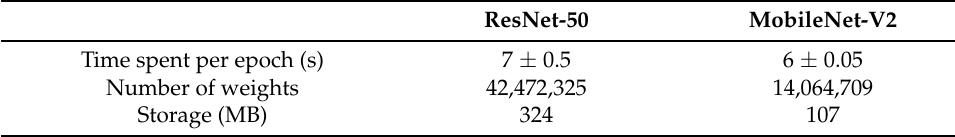
Table 5. Comparison of ResNet-50 and